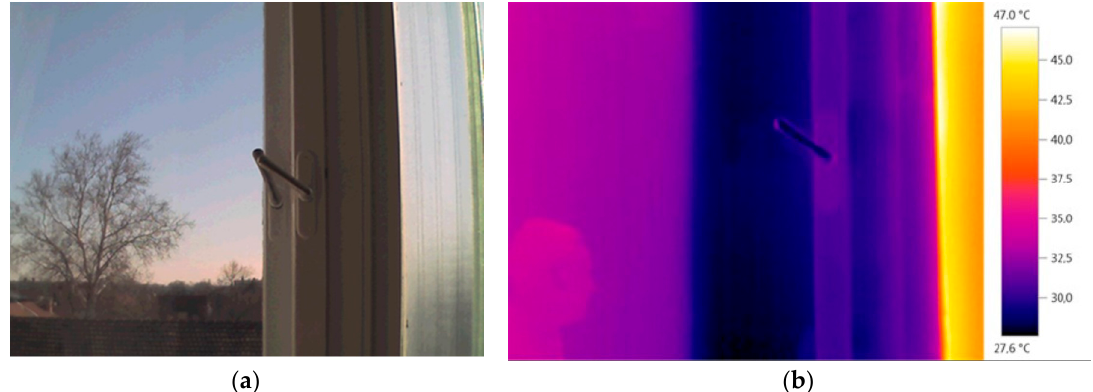
Figure 5. Normal ( a ) and infrared ( b ) photo of the window in the analyzed office.